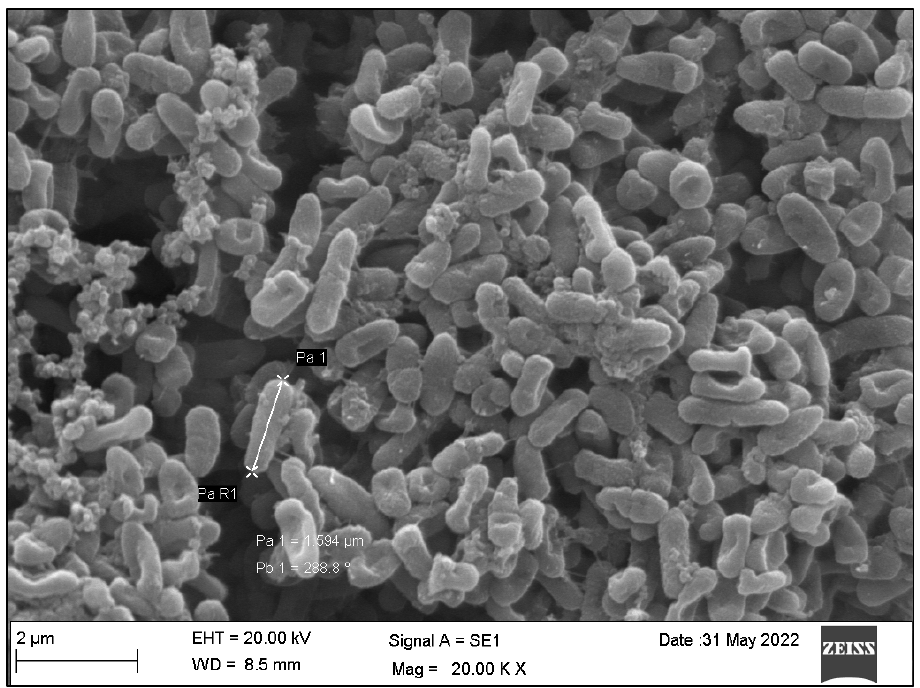
Figure 5. SEM appearance of PA as rod-shaped bacilli with varying shapes and sizes at 20 k magni- fication.